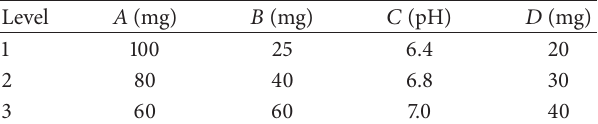
Table 1: Orthogonal factor level table.